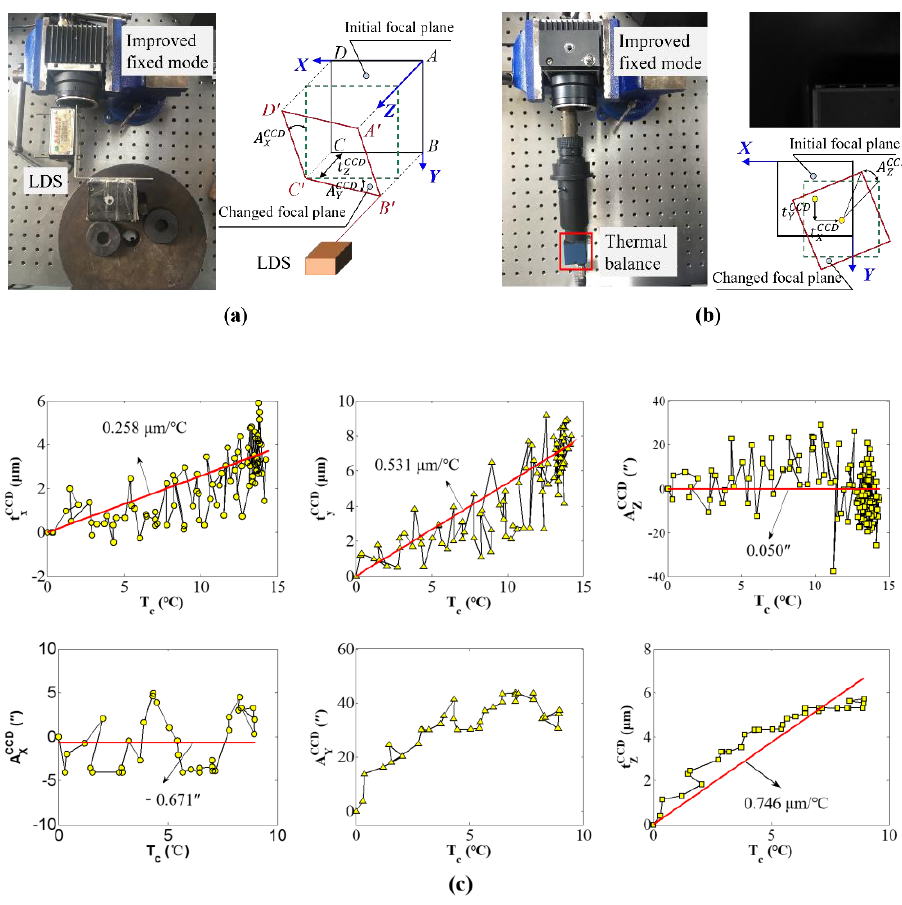
Figure 7. Thermal responses of rotations and translations of the CCD focal plane: ( a ) experimental arrangement for measuring out-plane thermal behaviours, ( b ) experimental arrangement for measuring in-plane thermal behaviours, and ( c ) responses of thermal behaviours to the case temperature.